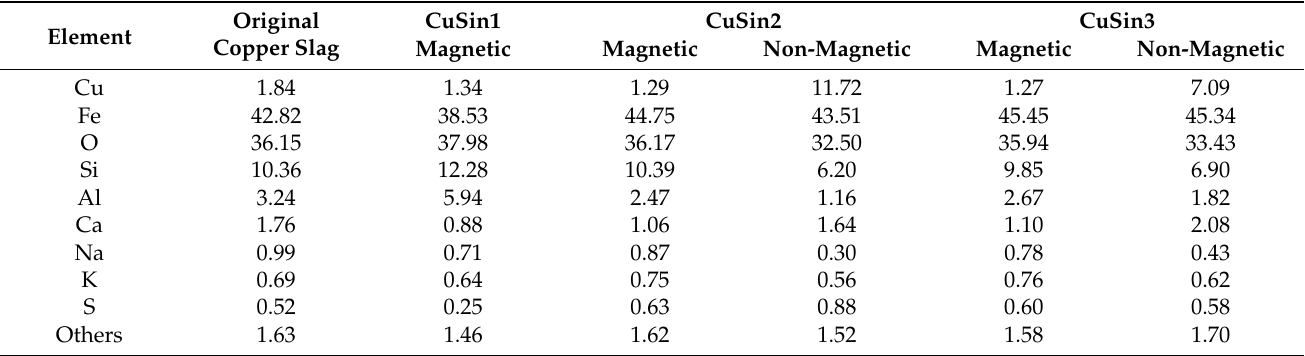
Table 4. X-ray fluorescence results.